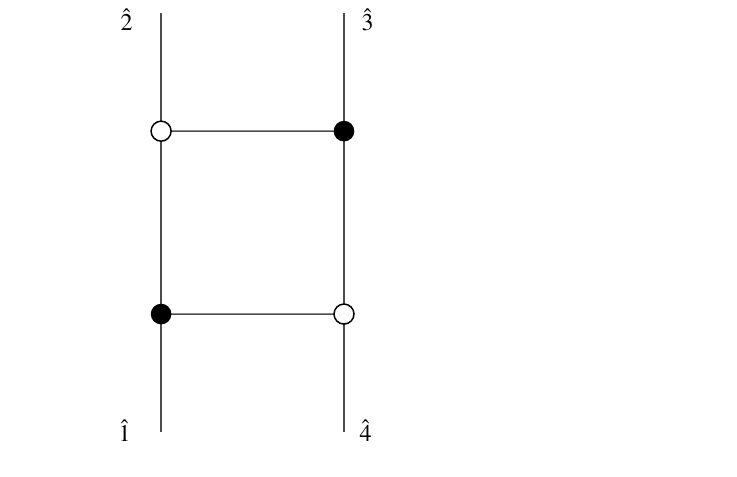
Figure 27 . On-shell diagram for the tree-level 4 point amplitude in N = 4 SYM with BCFW shifted